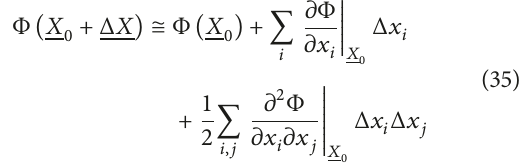
Figure 10: Variation of solar radiation.